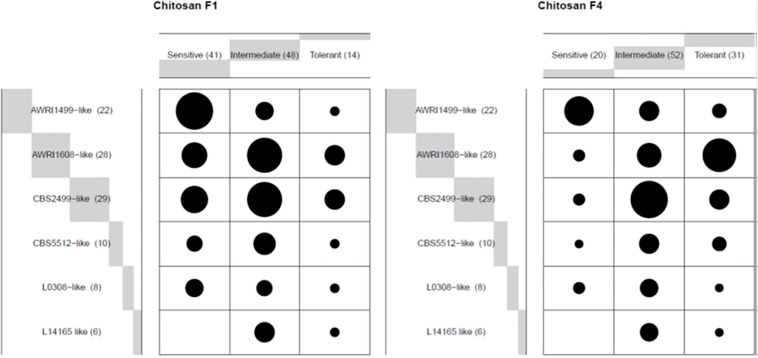
Frequency (ballon plot) of three profiles described in Figure 1, upon treatment with the indicated chitosan batch, for each genetic group in wine A. The circle area is proportional to the number of assays showing the corresponding profile.